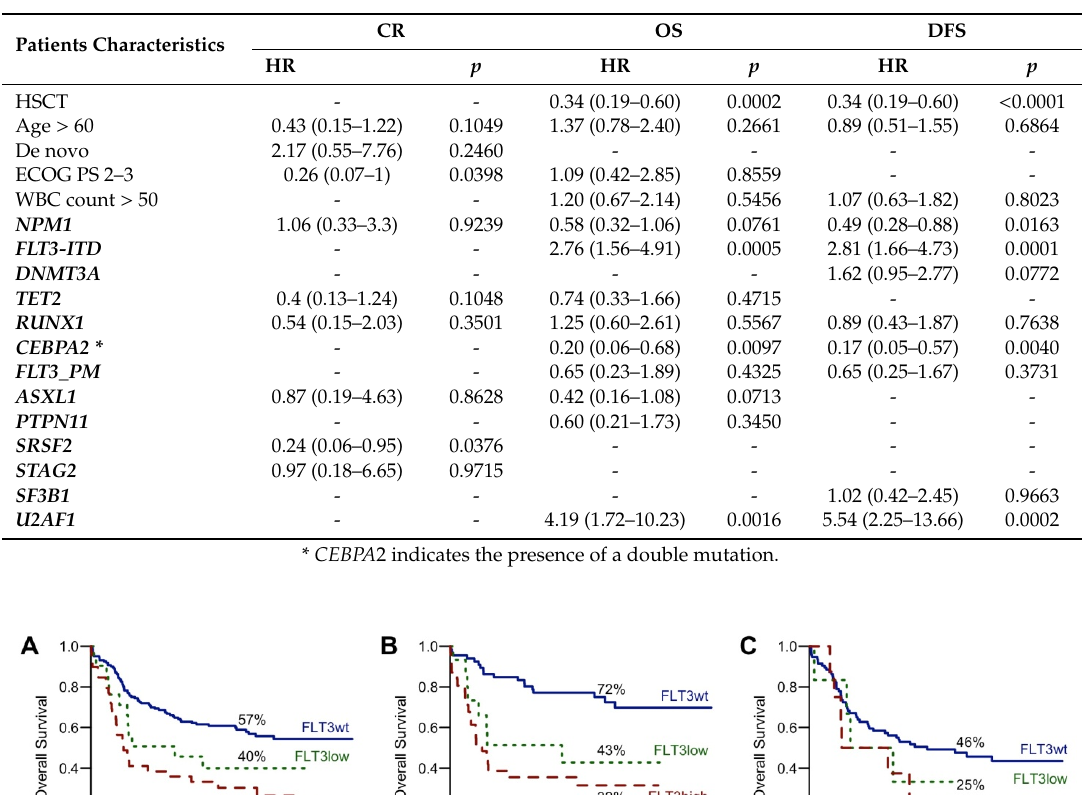
complete cohort.